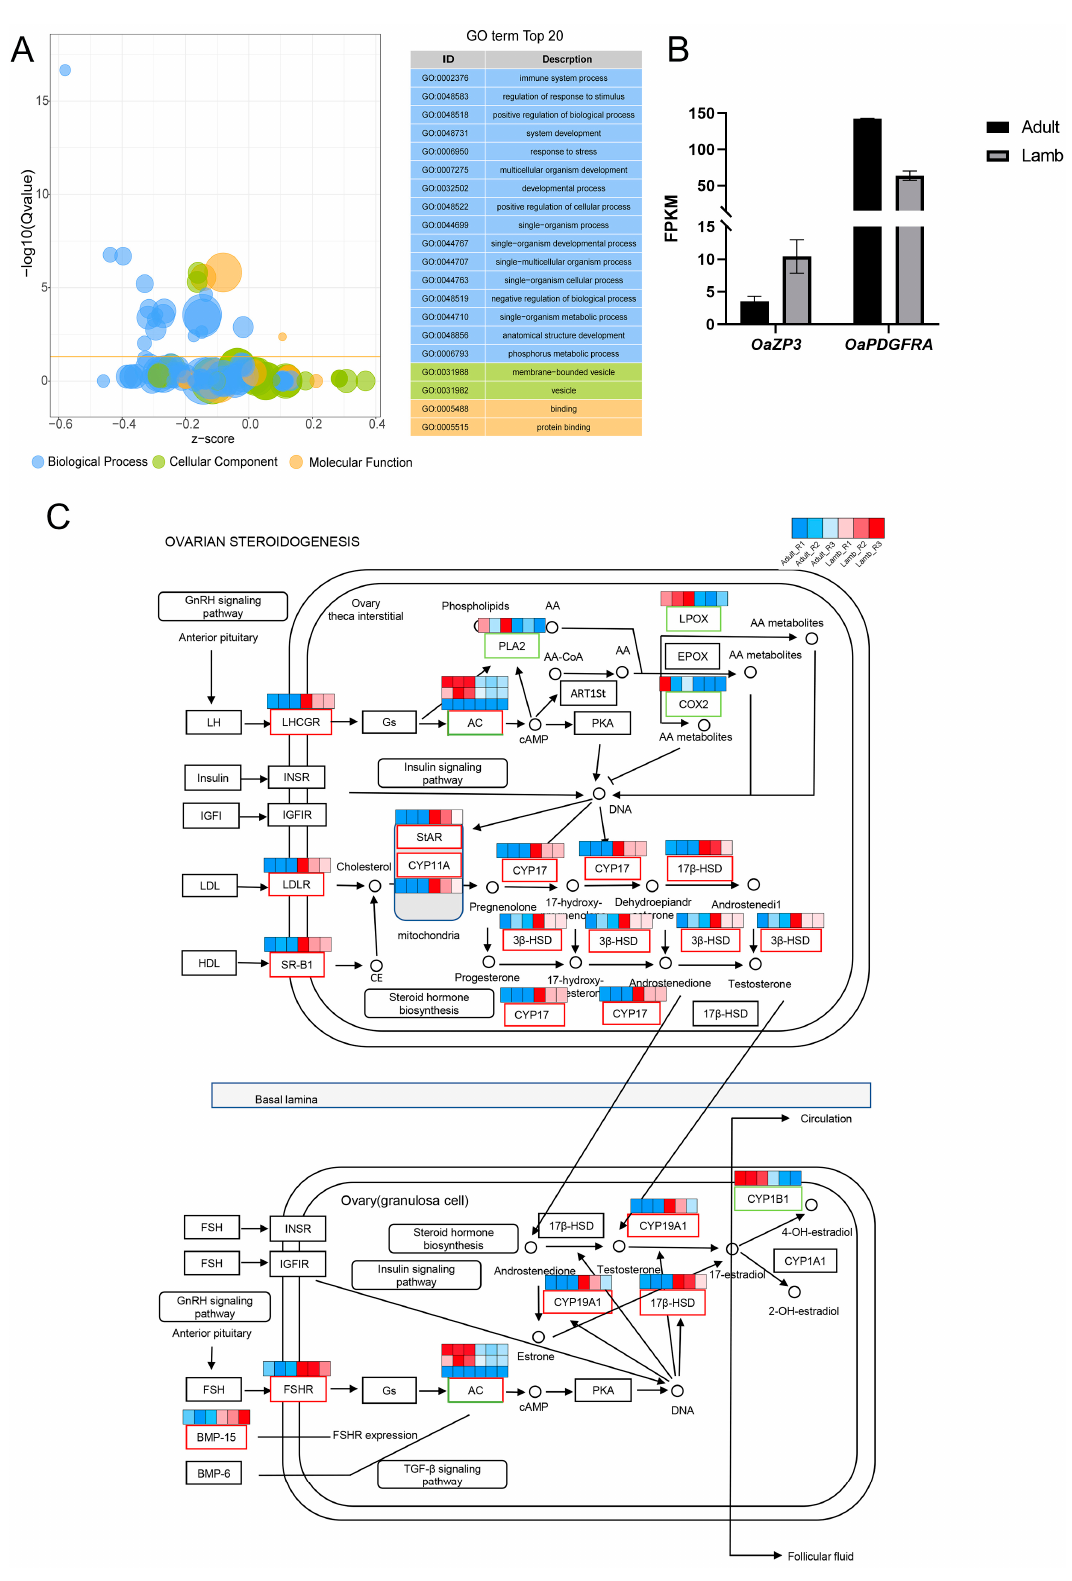
Figure 2. GO and KEGG functional analysis based on DEmRNAs. ( A ) Bubble plot for visualizing the top 20 enriched GO terms; every bubble represents a gene set; the bigger the bubble size, the higher the number of genes in the gene set. ( B ) The expression level of OaZP3 and OaPDGFRA . ( C ) The heatmap of DE mRNAs involved in the ovarian steroidogenesis pathway; the higher the expression level, the redder the color, and the lower the expression level, the bluer the color.